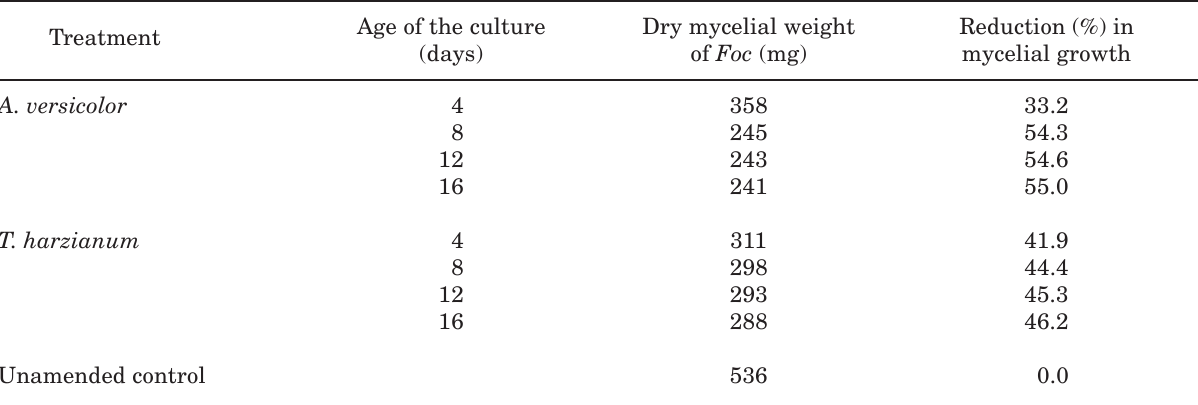
Table 1. Effect of cell-free culture filtrates of Aspergillus versicolor and Trichoderma harzianum on mycelial growth of Fusarium oxysporum f. sp. cumini ( Foc ) Treatment